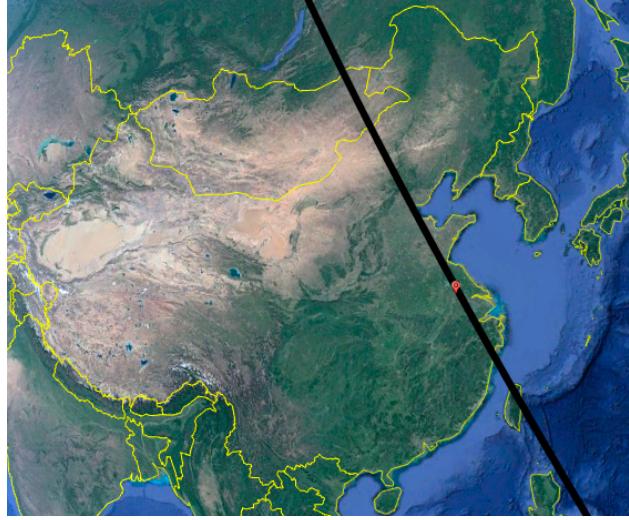
Figure 2. The track map for CALIPSO transiting Nanjing.